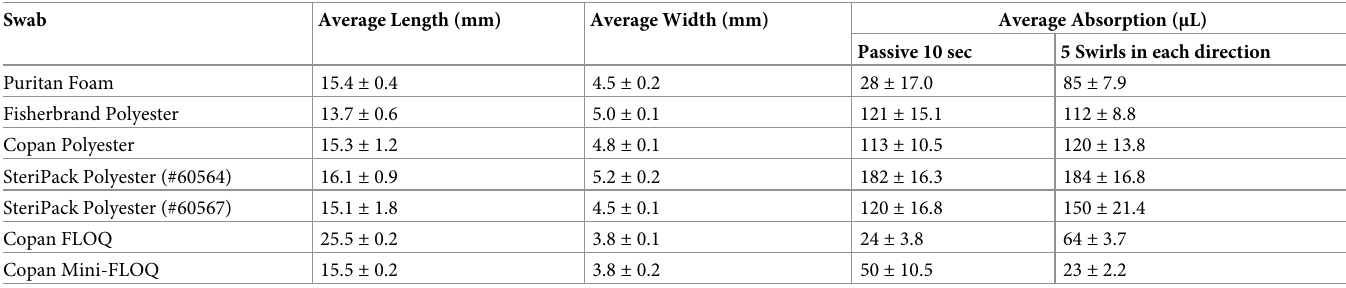
Table 1. Average swab dimensions and absorption volumes ± standard deviation (n =